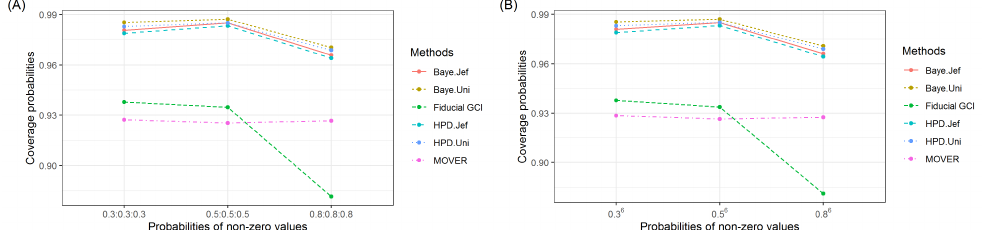
Figure 4. Coverage probabilities of the 95% simultaneous CIs with various probabilities of nonzero values: ( A ) k = 3 and ( B ) k = 6.